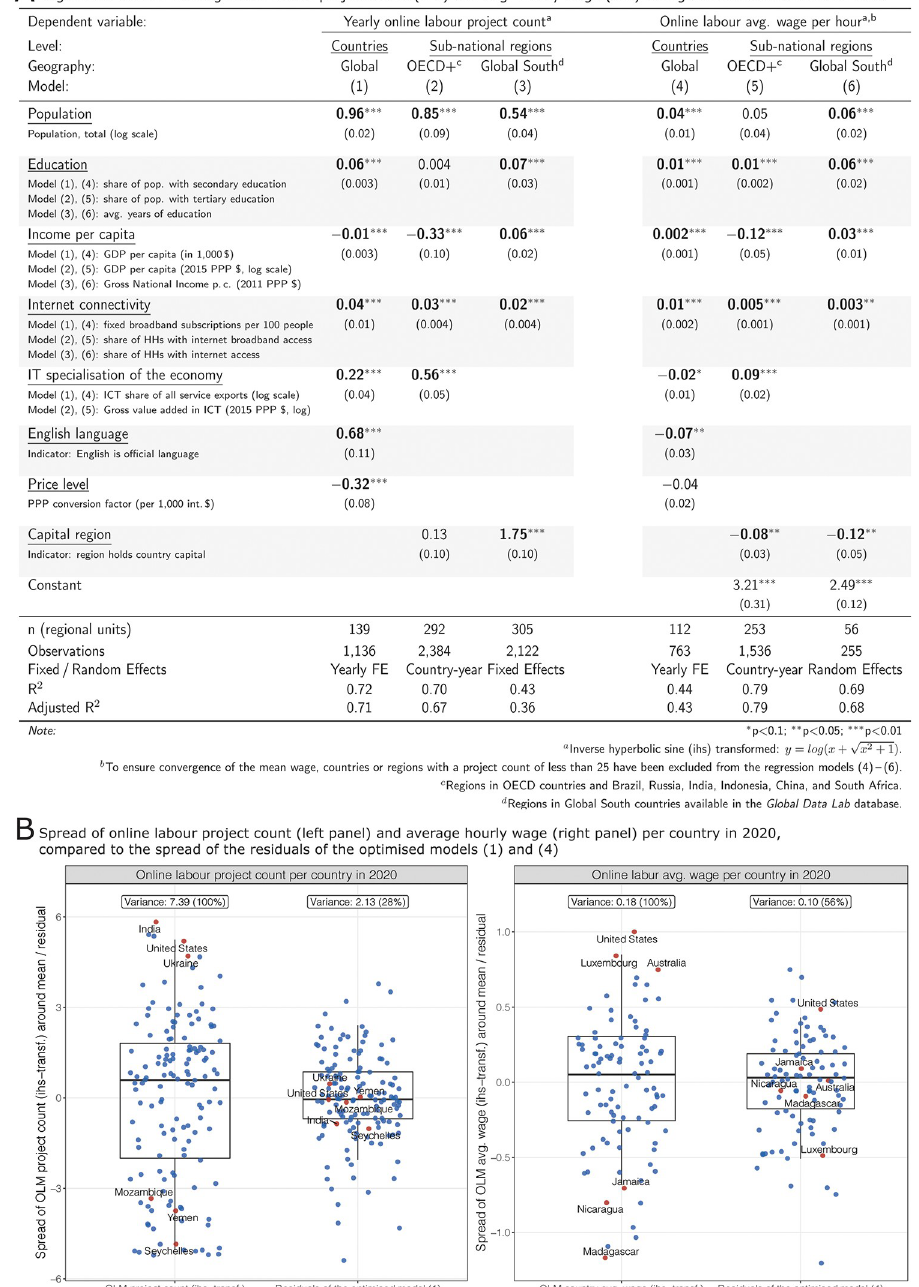
Fig 2. ( A ) Regressions between online labour project count (models 1—3), avg. hourly wage (models 4—6) and regional covariates (2013—2020 data, in total 1.76 million projects): population, education, internet connectivity, and the IT specialisation of the economy are positively associated with project count and hourly wages; globally, countries with English language and low price levels are more active in the remote labour market. ( B ) Spread of online labour (OLM) project count (left panel) and avg. hourly wage (right panel) per country vs. residuals of the regression models (1) and (4): the parsimonious models explain large shares of the global variation; for example, the countries at both ends of the project and wage spectrum (highlighted in red) show substantially reduced residuals after controlling for regional covariates. Overall, the regression models explain between 42% and 79% of the variation between countries or